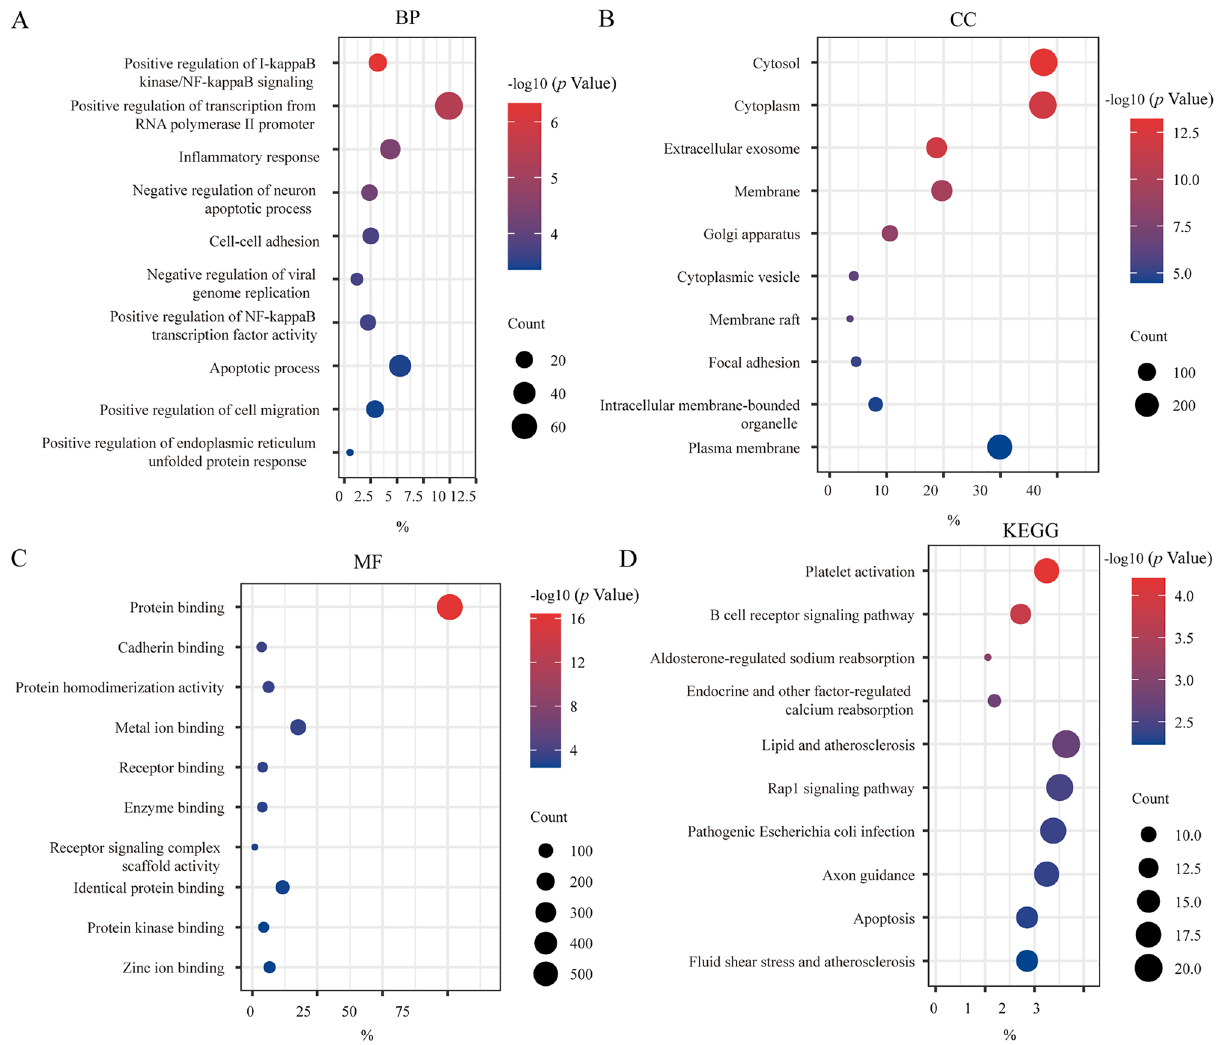
Figure 2. DEGs functional enrichment analysis. ( A ) BP biological process, ( B ) CC cellular component, ( C ) MF molecular function, ( D ) KEGG